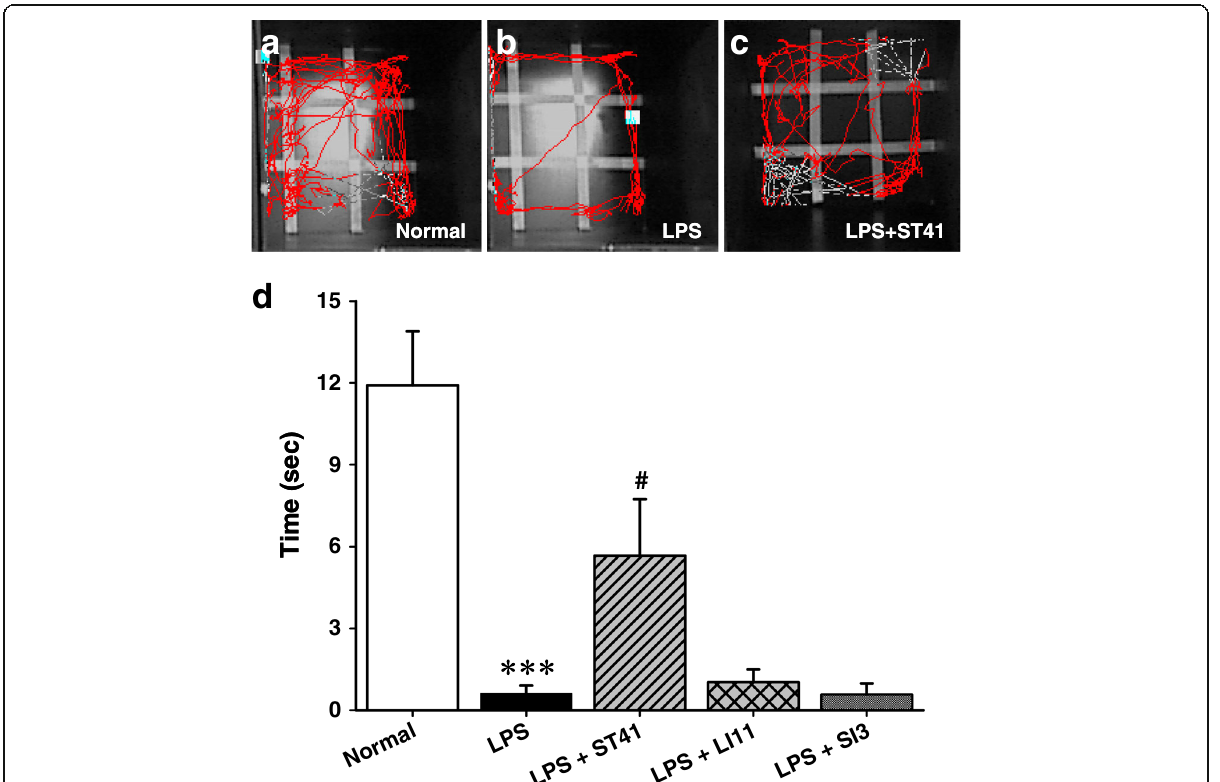
Fig. 3 Effect of acupuncture on LPS-induced anxiety-like behavior in the OFT. a-c Representative examples of traveling pattern for 5 min in the open field. d Time spent in the center of zone for 5 min presented as mean ± SEM. While LPS-treated rats spent less time in the center zone of open field arena compared to control, acupuncture at ST41, but neither LI11 nor SI3, spent more time in center zone of open field arena compared to LPS-treated rats. *** P < 0.001 vs. control, # P < 0.05 vs. LPS; n = 6 – 7 per